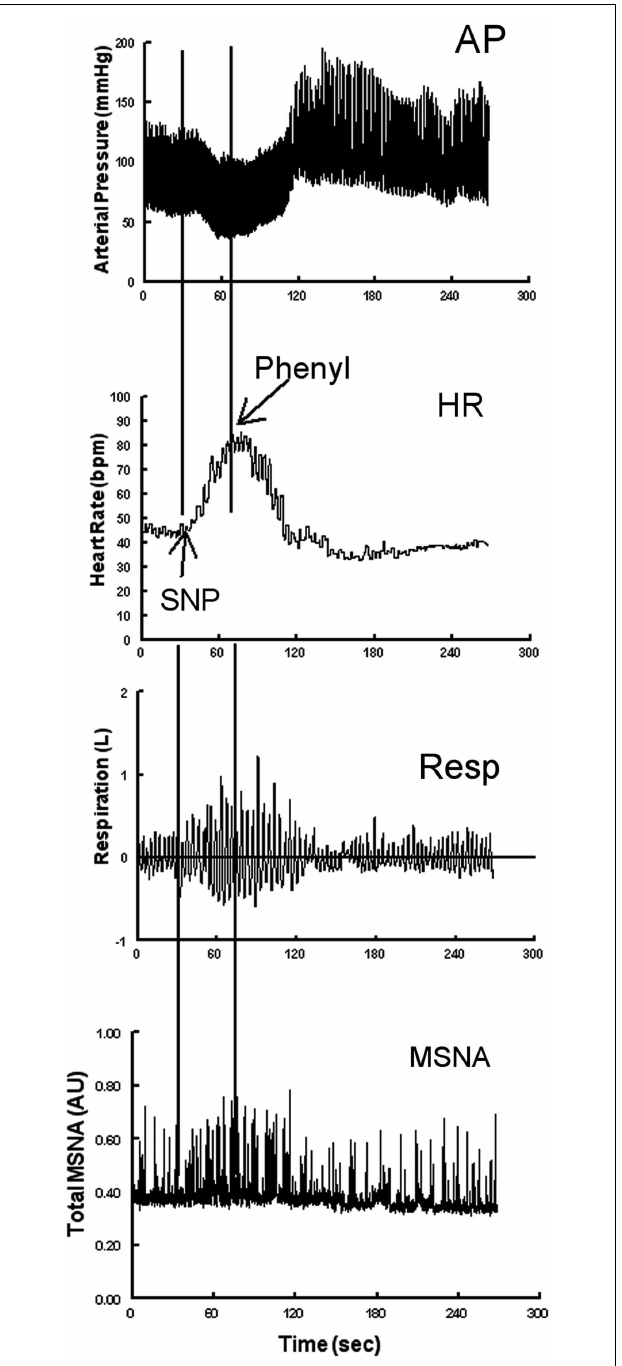
FIGURE 1 | Representative neurovascular and respiratory responses to the modified Oxford maneuver in which a sodium nitroprusside (SNP) bolus is followed 1min later by phenylephrine. From top to bottom the figure shows arterial pressure, heart rate, respirations, and MSNA bursts.